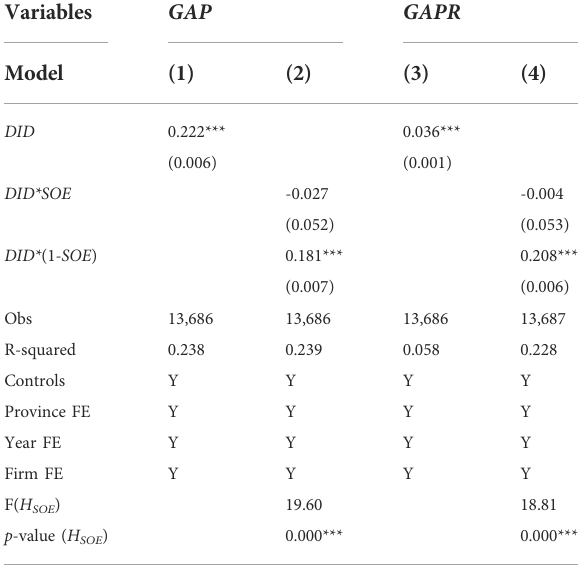
TABLE 12 Industry chain position mechanism estimation results. TABLE 13 Green innovation mechanism estimation